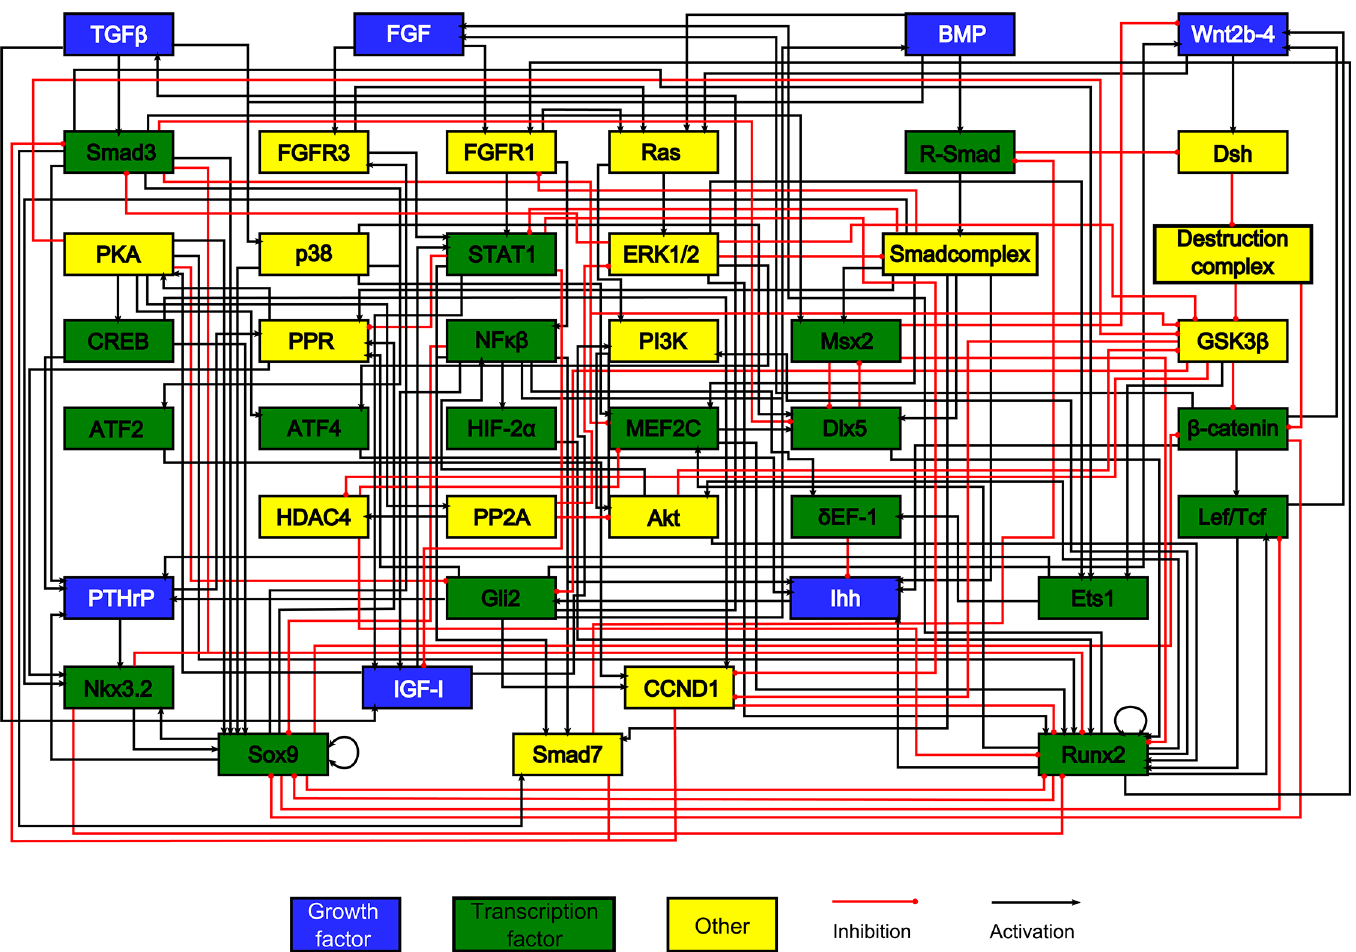
Fig 1. The chondrocyte gene network. Every box represents a gene, its protein or in some cases a complex of them. The interactions are represented by red and black lines if they are inhibitory and stimulatory, respectively. Blue boxes denote growth factors, green boxes are transcription factors, yellow boxes do not belong to either category. Based on